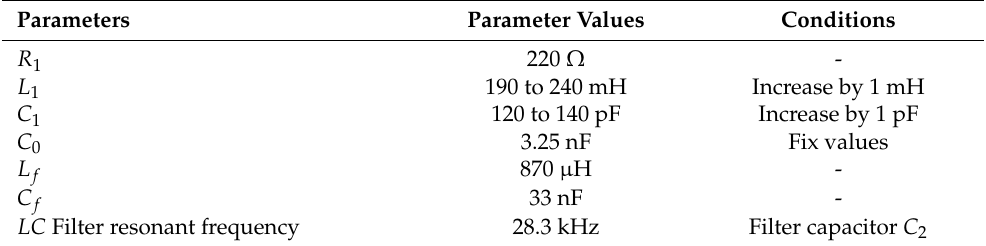
Table 2. Practical application areas of medical piezo element MATLAB simulation conditions. Parameters Parameter Values